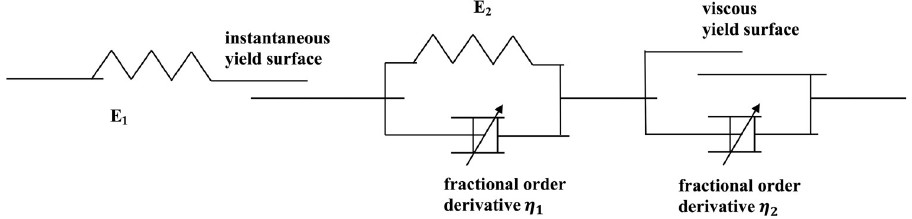
Fig 1. Developed fractional differential constitutive model of soft